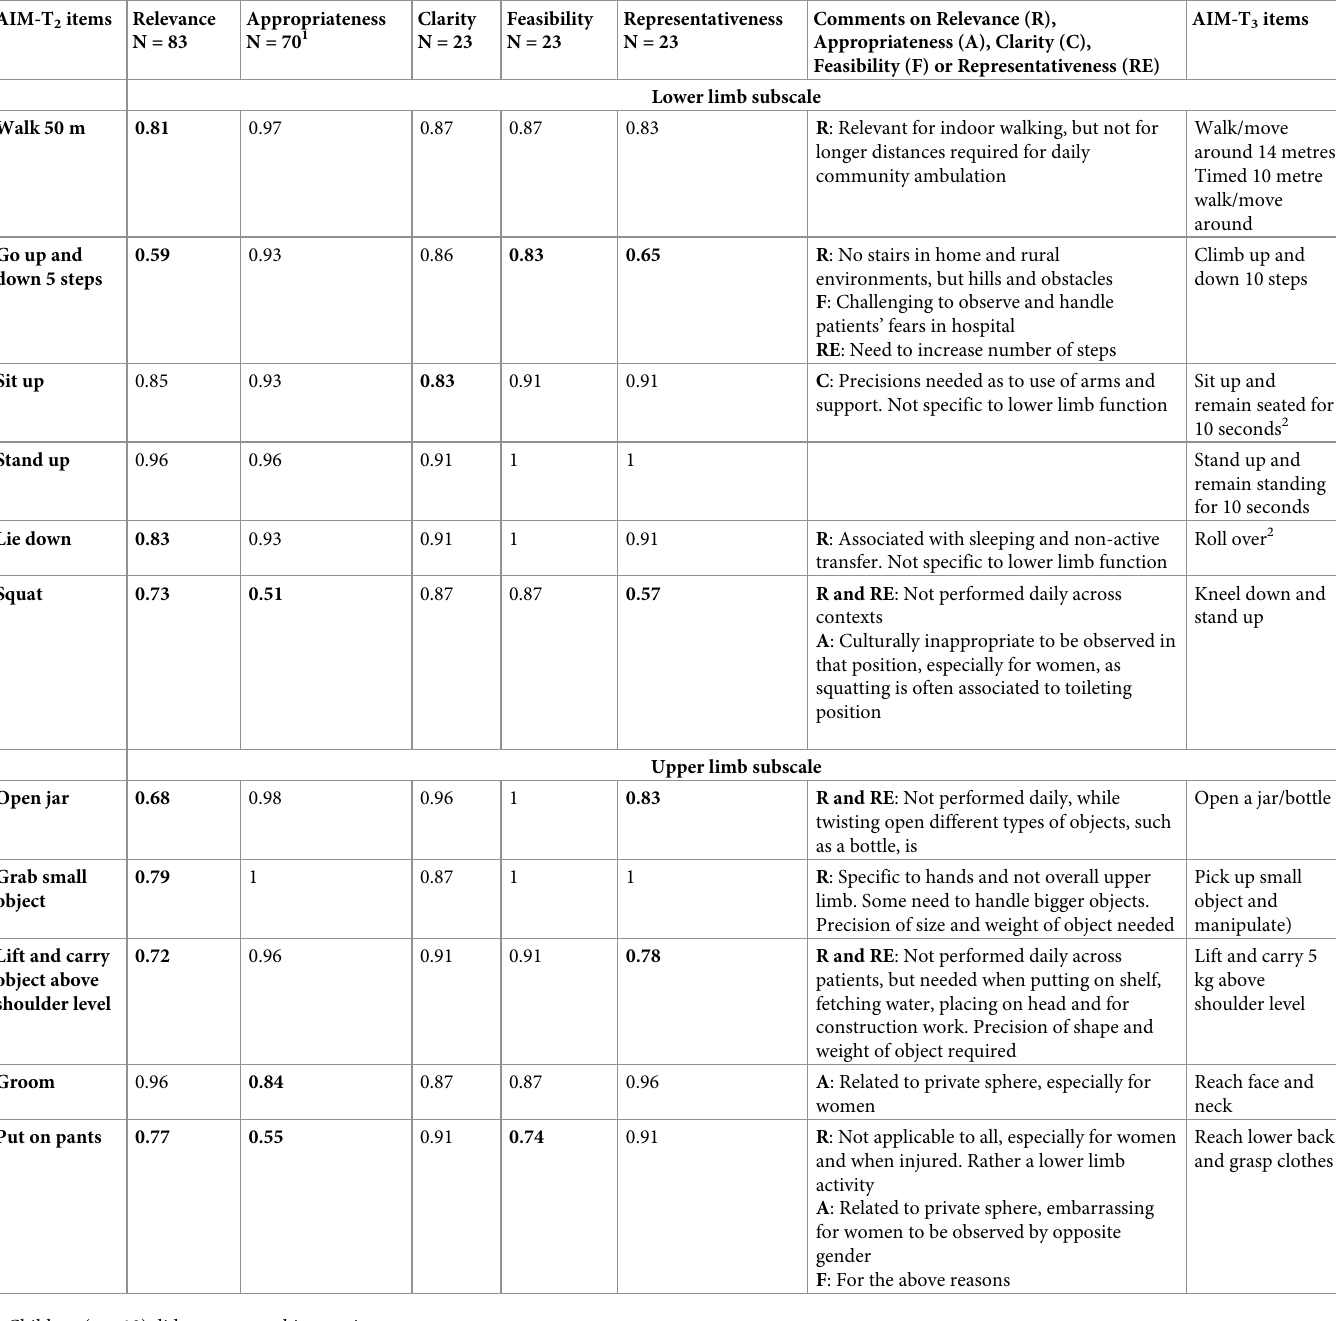
Table 4. Item Content Validity Indices (I-CVI) of the AIM-T 2 items in terms of relevance, appropriateness, clarity, feasibility and representativeness, as expressed by patients (n = 60) and healthcare professionals (n = 23). Comments on I-CVIs < 0.85 (in bold) are included as well as revisions of items for AIM-T 3